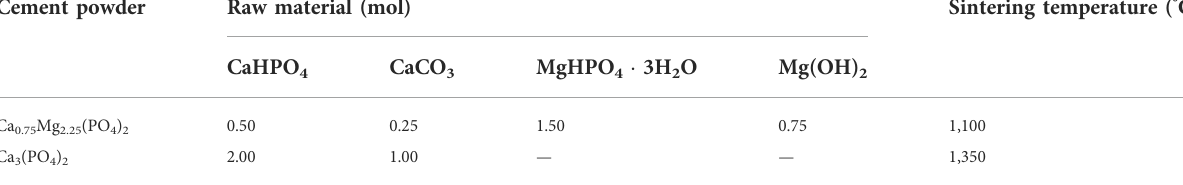
TABLE 1 Powder synthesis: Composition of the cement powders and sintering temperature of the raw powders. Cement